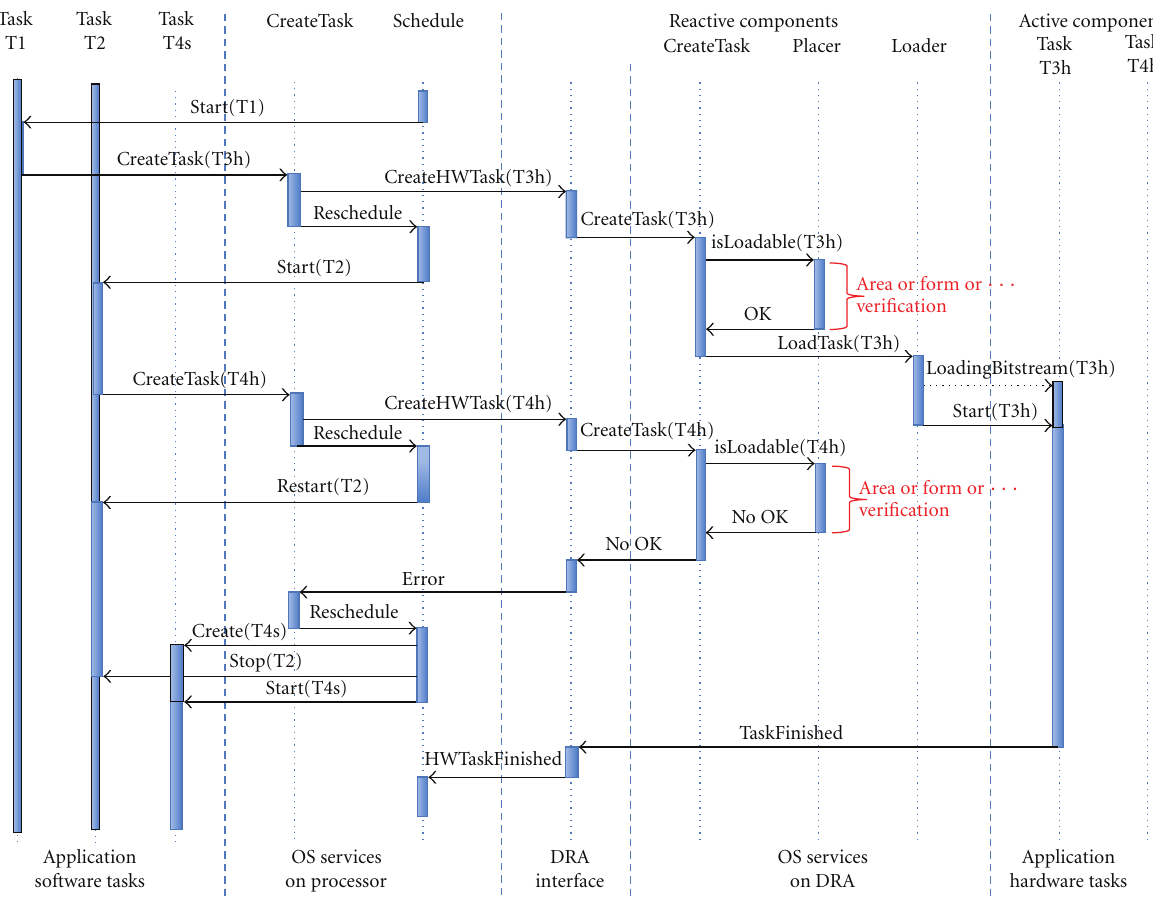
Figure 11: Sequence diagram of the CreateTask service implementation. After a Create task system call a sequence of system call depends on the services implemented on the DRA. Here we can evaluate and develop the loader and the placer services of the DRA dedicated